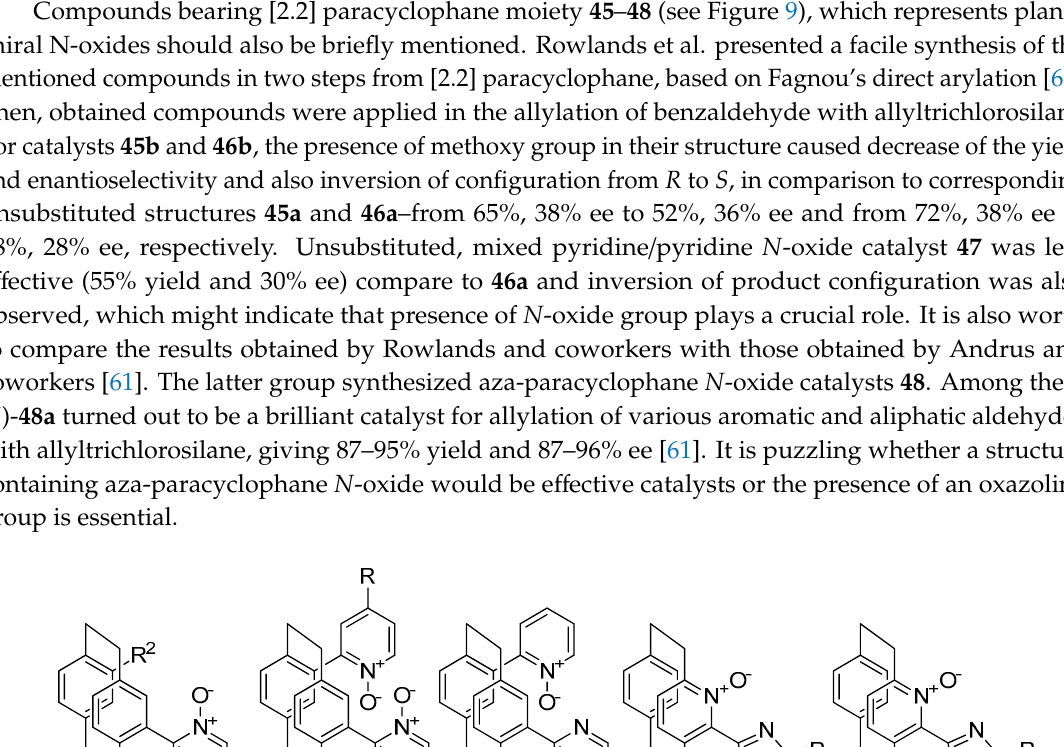
Figure 10. N- oxide ligands used in Cu-catalyzed nitroaldol reaction. 4. Other Applications of Pyridine N -Oxides